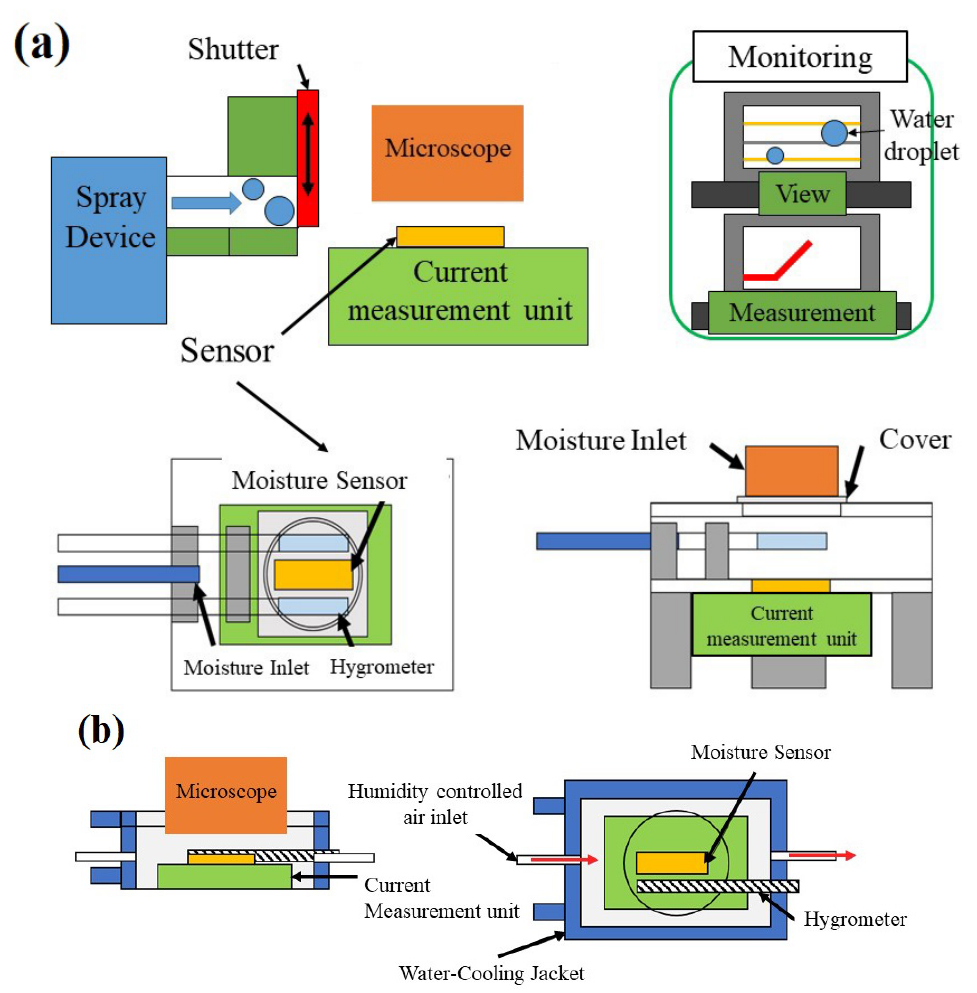
Figure 2. Schematic diagram showing an experimental setup for the introduction of a water droplet onto a moisture sensor ( a ) using a spray method and ( b ) by humidity-controlled air, while observing through a microscope and measuring the